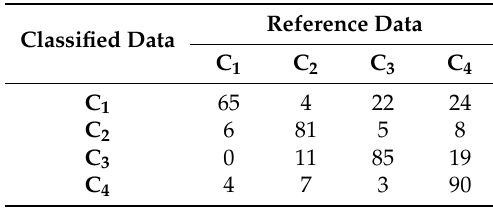
Table 3. Confusion matrix P.